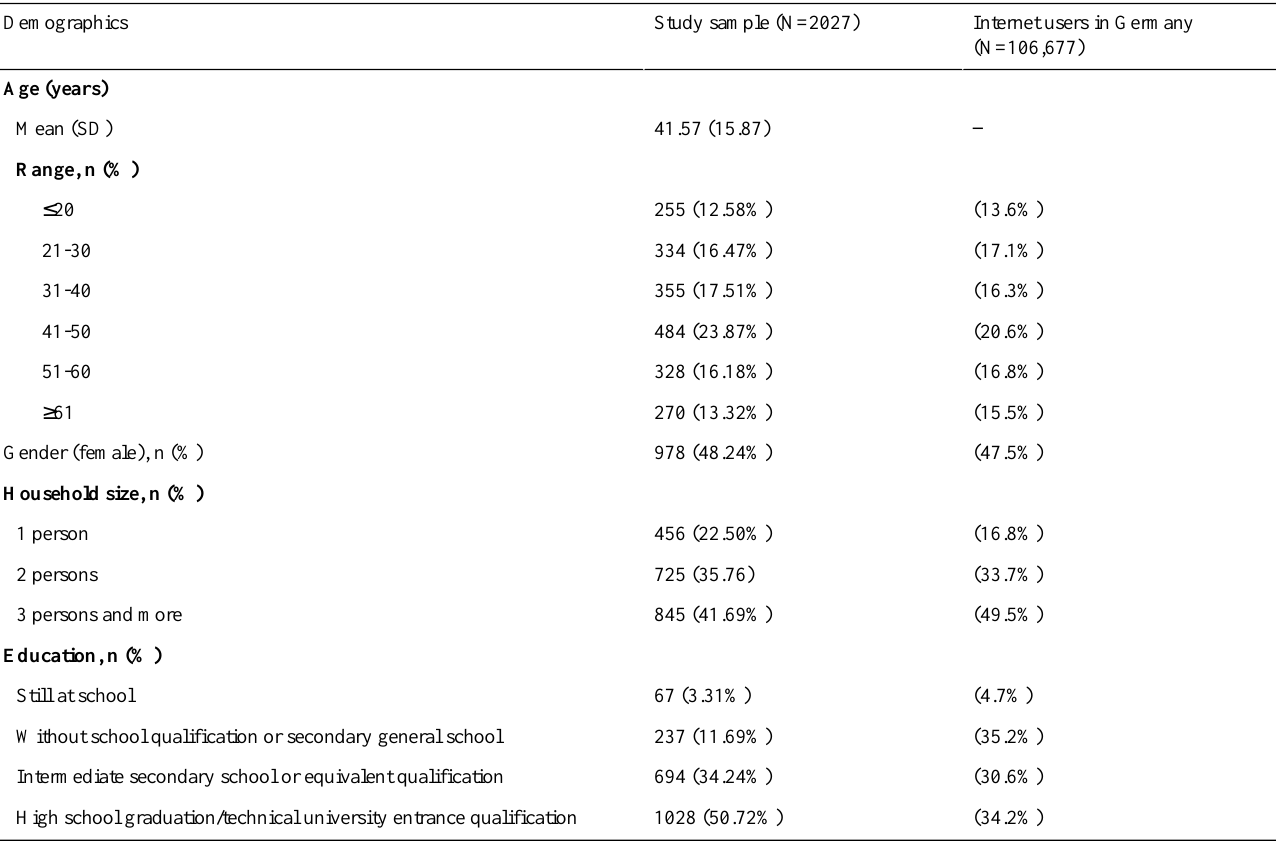
Table 3. Overview of the study sample in comparison with Internet users in Germany.